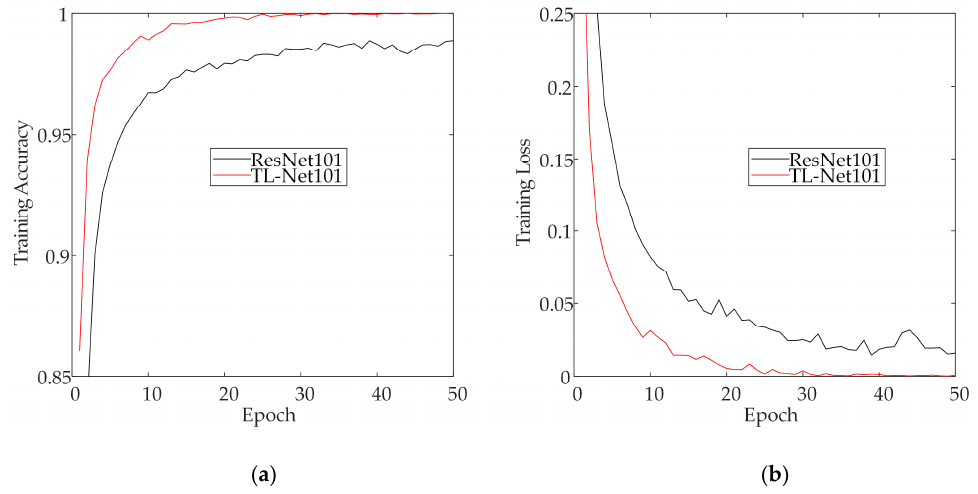
Figure 12. ( a ) The training accuracy curves of ResNet101 and TL-Net101; ( b ) the training loss curves of ResNet101 and TL-Net101 .